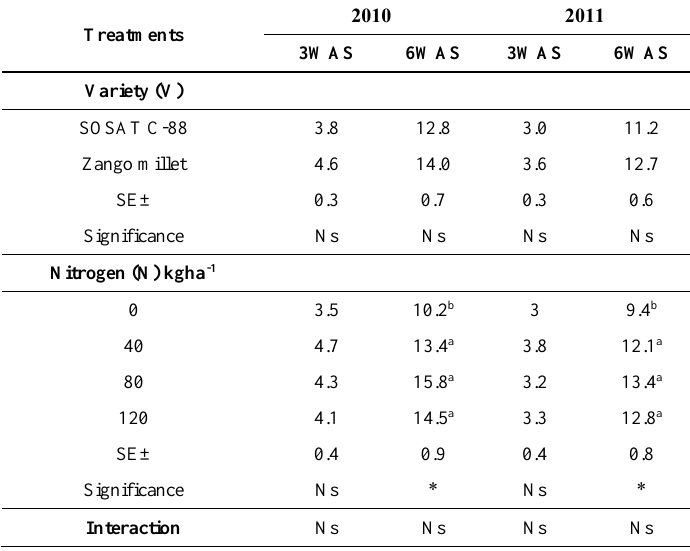
Table 2. Effect of varieties, nitrogen levels on Tiller count at 3WAS and 6WAS during 2010 and 2011 cropping seasons at Usmanu Danfodiyo University Teaching and Research Dry Land Farm, Sokoto